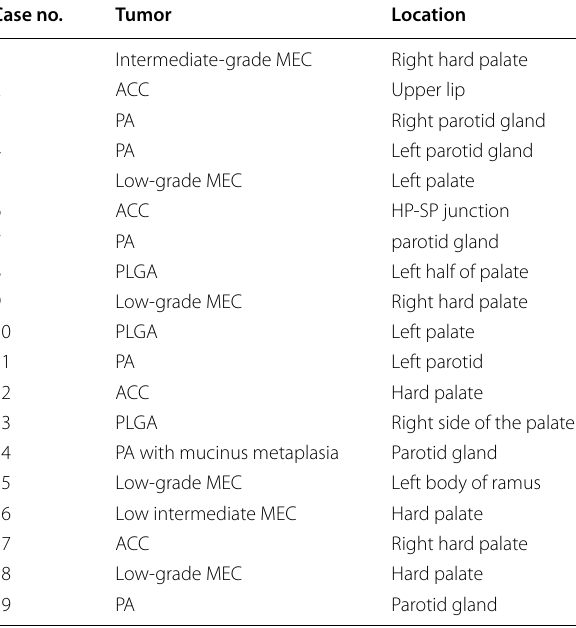
ACC adenoid cystic carcinoma, MEC mucoepidermoid carcinoma, HP-SP hard palate-soft palate, PA pleomorphic adenoma, PLGA polymorphous low-grade adenocarcinoma